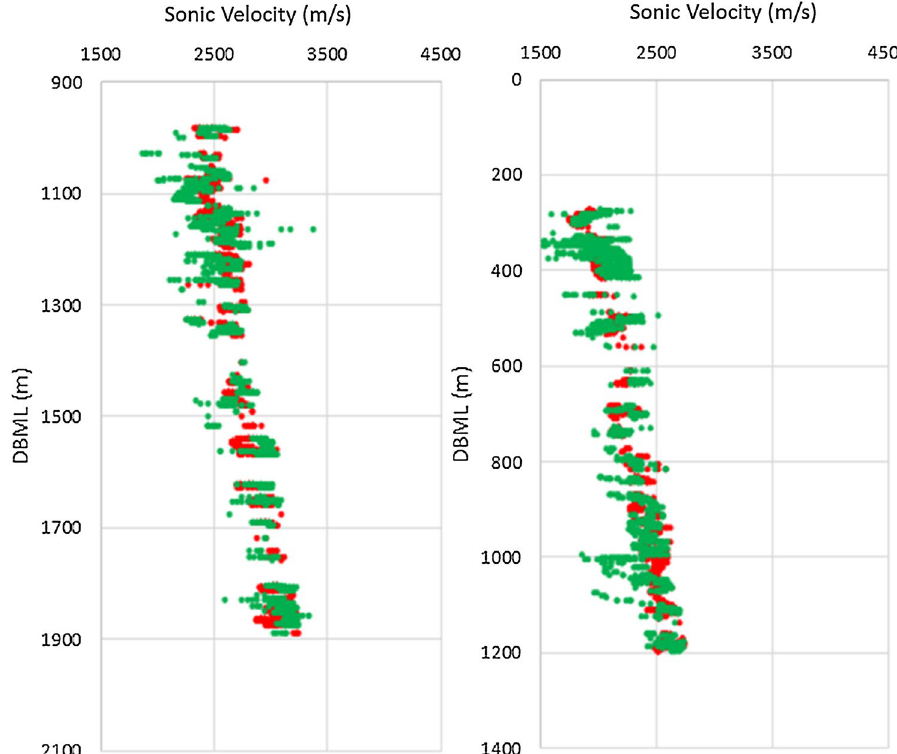
Fig. 5 Predicted velocity (green) overlaid on recorded velocity (red) for two nearby vertical